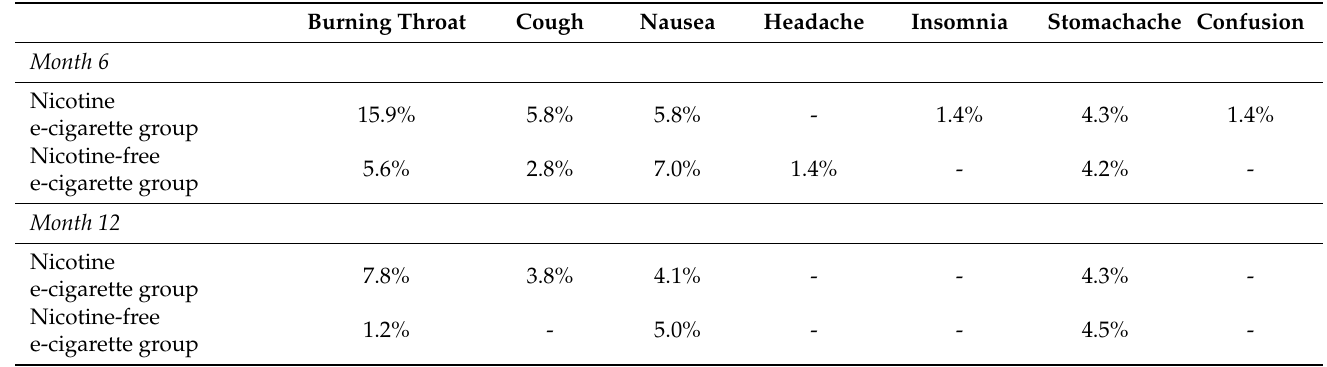
Figure 3. Change in anxiety level as measured by HAD subscale throughout the study. Table 3. Side-effects. Here we describe participants’ subjective reports about e-cigarettes’ side-effects. Burning throat decreased from 6 to 12 months, which may be considered the only relevant symptom potentially related to the habitual use of e-cigarettes (Table 3). Answers were collected through an interview by health personnel concerning the last 6 months.